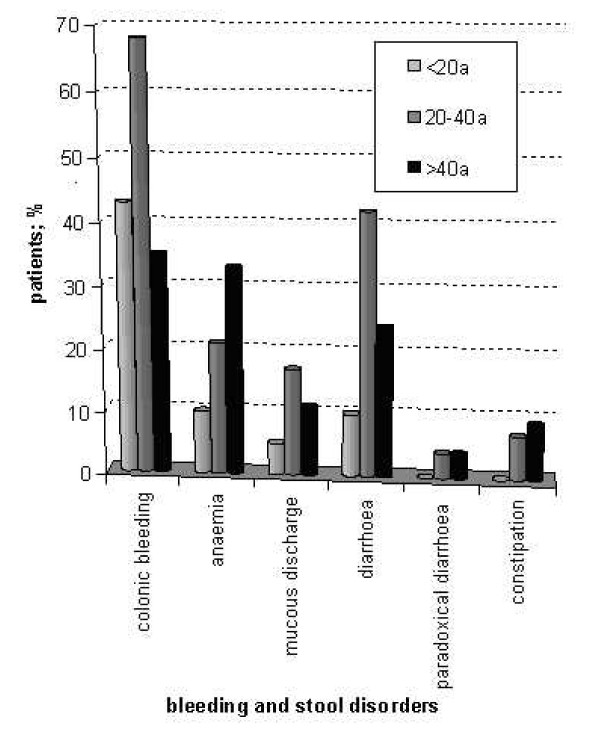
„Bleeding and stool disorders“ on primary diagnosis of FAP (n = 143 patients, realtive values regarding the corresponding subgroup of age)